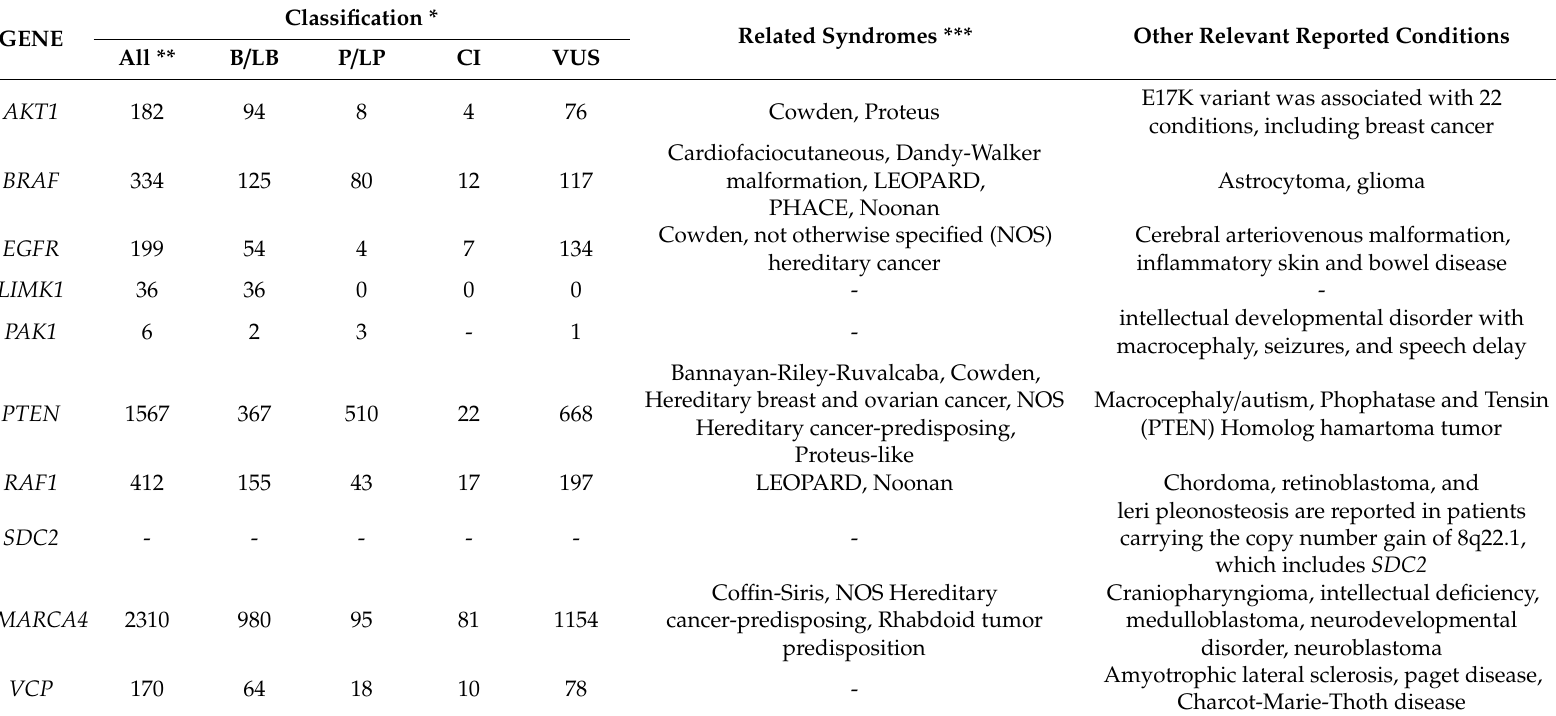
Table 3. Germline variants submitted to ClinVar database for each candidate gene. The number of variants is presented according to its classification. Related syndromes and other relevant conditions for NF1 phenotype are also